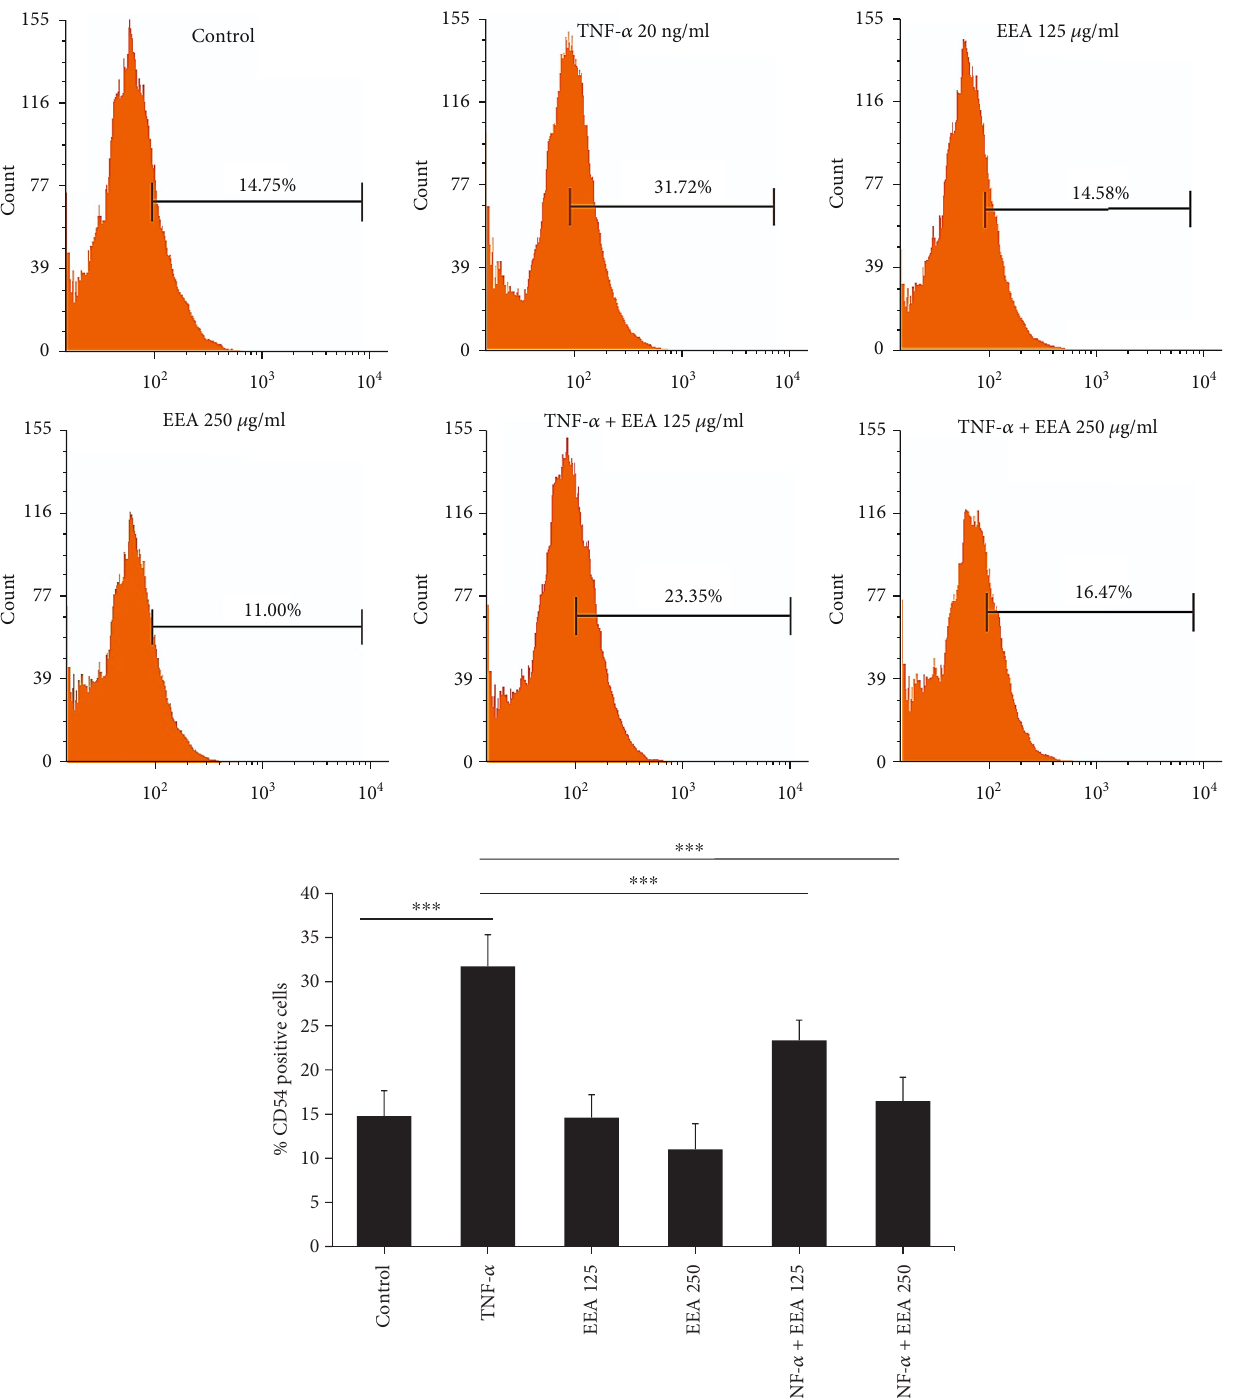
Figure 4: The outcome of EEA upon on surface expression of ICAM-1 in TNF- α -stimulated HUVECs by fl ow cytometry. At fi rst, HUVECs were treated with or without Assafoetida (125 and 250 μ g/ml) for 6h, and after that, activated with TNF- α (20 ng/ml) for 12 h. TNF- α increases ICAM-1 expression, but Assafoetida inhibits its expression explicitly. The parameters are reported as the mean ± S : D : for at least three separate experiments. ∗∗∗ p < 0 : 0001 compared with the control and TNF- α -treated